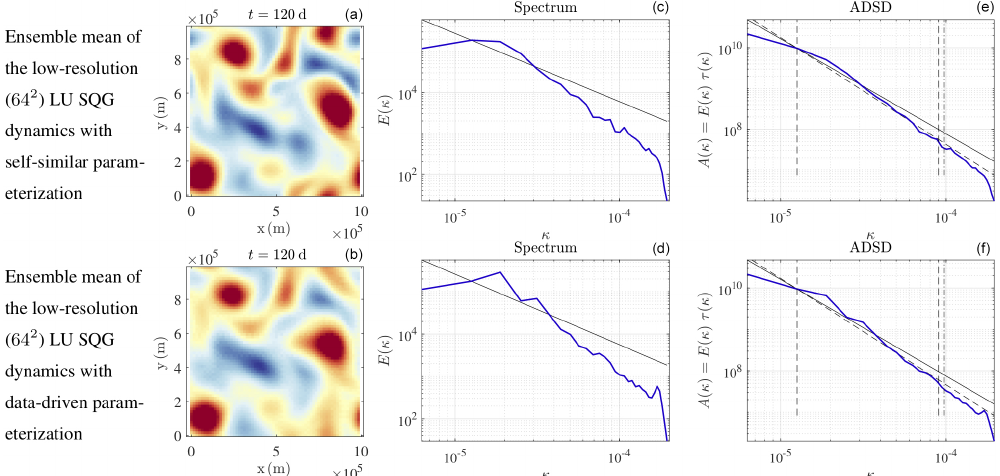
Figure 11. Buoyancy fields (ms − 2 ) (a, b) , kinetic energy spectra (m 2 s − 2 / (radm − 1 )) (c, d) , and ADSDs (m 2 s − 1 / (radm − 1 )) (e, f) of w , at t = 120d, for the ensemble mean of the low-resolution (64 2 ) LU SQG dynamics (equivalent to SALT SQG) with self-similar parameteriza- tion (a, c, e) and with data-driven parameterization (b, d, f)